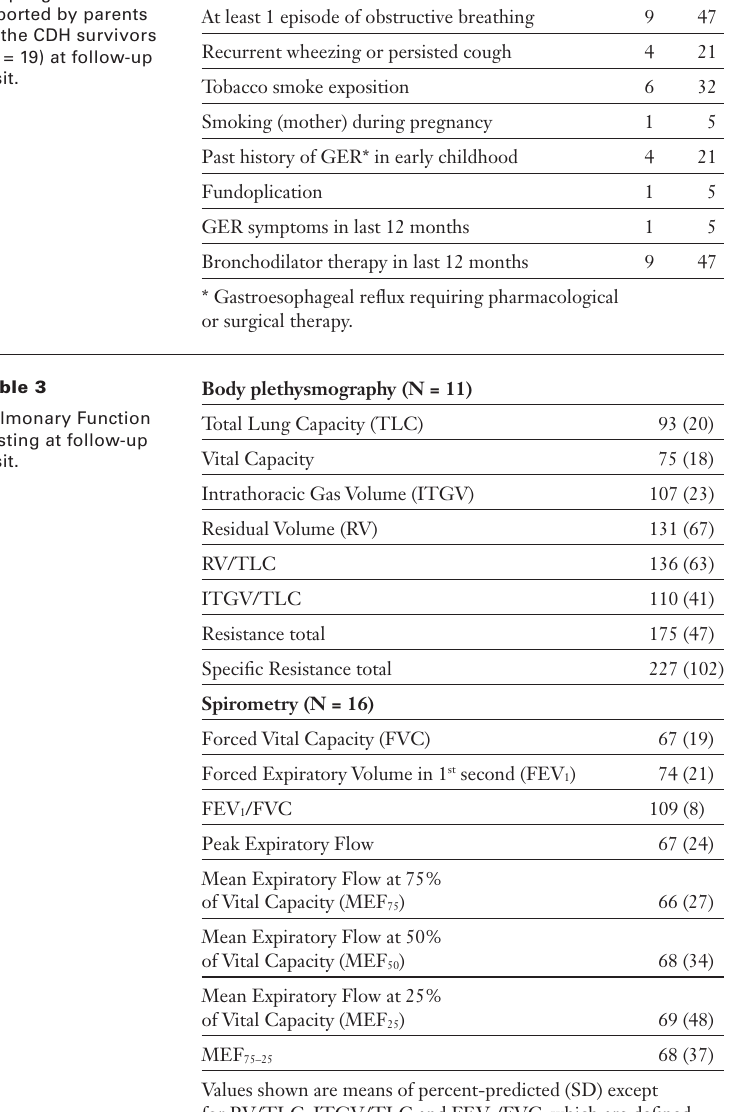
Data from question- naire regarding the respiratory prob- lems and gastro - esophageal reflux as reported by parents of the CDH survivors (N = 19) at follow-up visit.